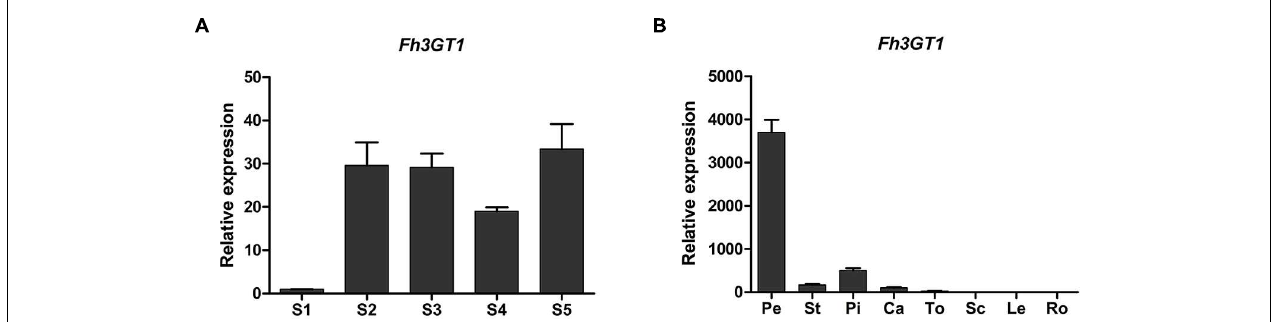
FIGURE 3 | Expression profiles of Fh3GT1 gene in Freesia hybrida . (A) Expression levels of Fh3GT1 in flowers at different developmental stages. (B) Expression profiles of Fh3GT1 in different tissues. Data represent means ± SD of three biological